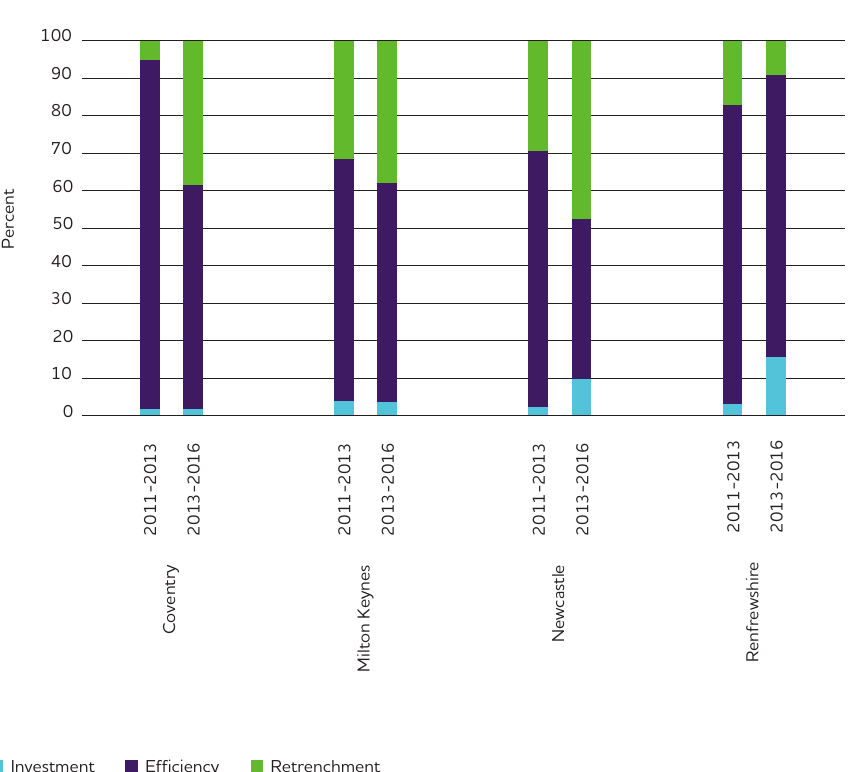
Figure 16: Comparison of 2011-2013 and 2013-2016 savings by headline